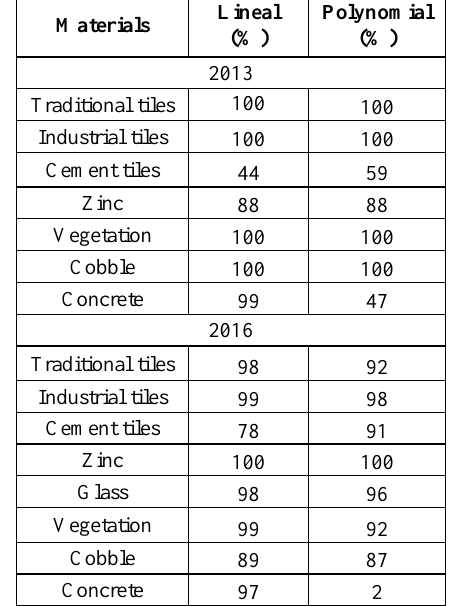
Table 6: Classifier precision percentages, identified by its materials. Source: Authors,